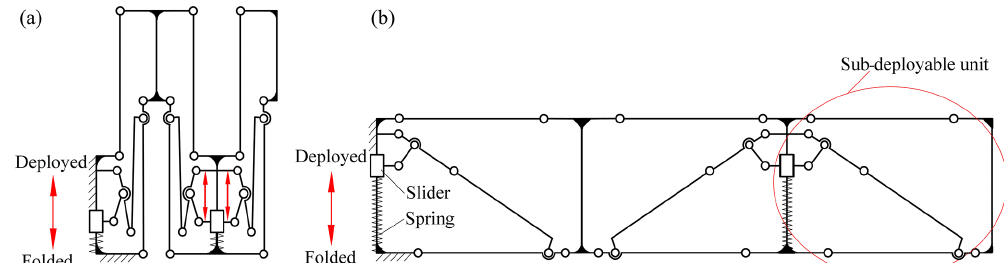
Figure 4. Structures of a rib unit. (a) Folded. (b)